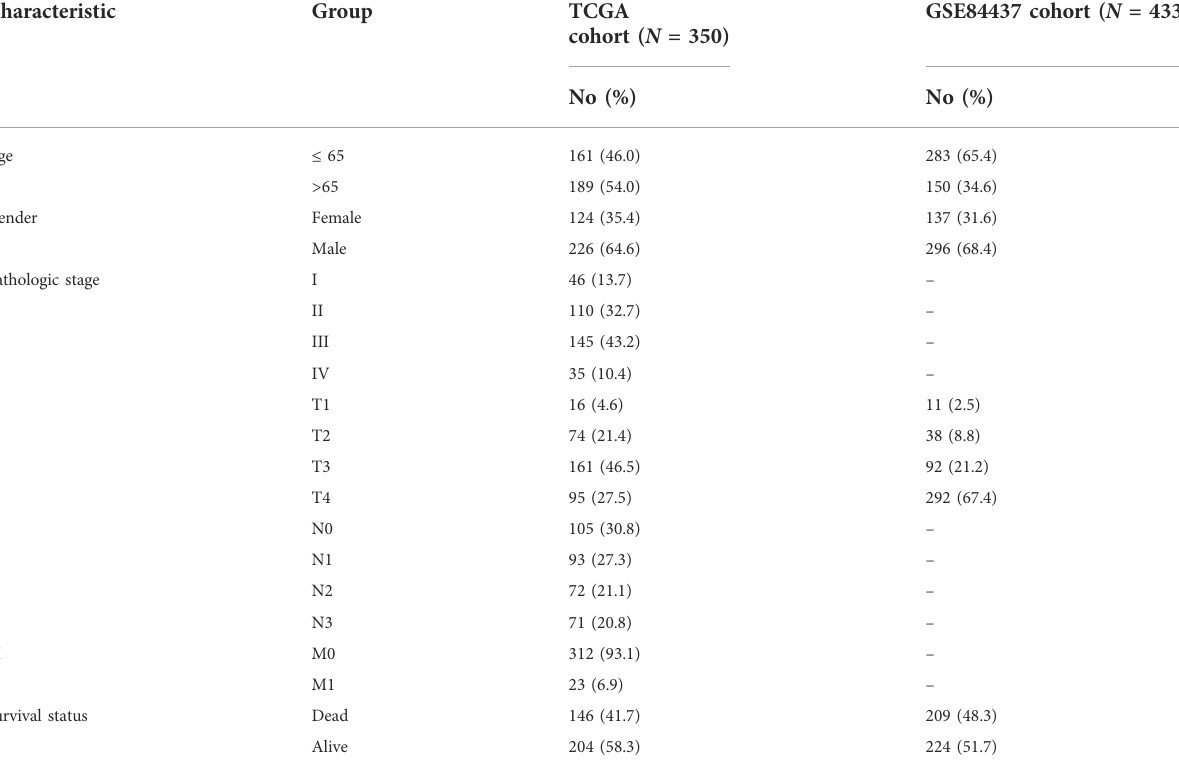
TABLE 1 Basic characteristics of stomach adenocarcinoma patients.